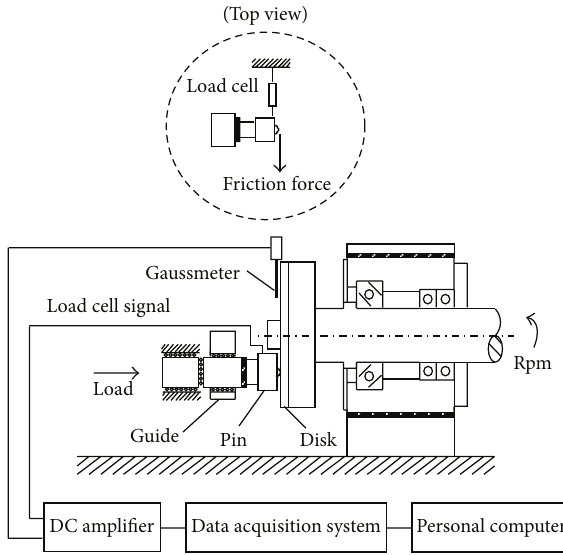
Figure 1: Schematic diagram of ball/disk friction tester with the measuring systems.